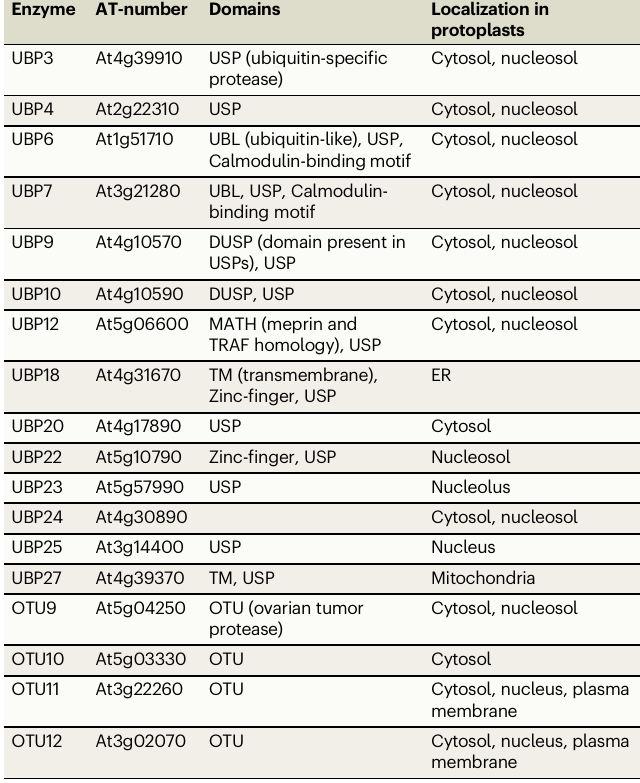
Table 1 | Summary of the AT-numbers, domains, and the localization pattern of the DUBs used in this study Enzyme AT-number